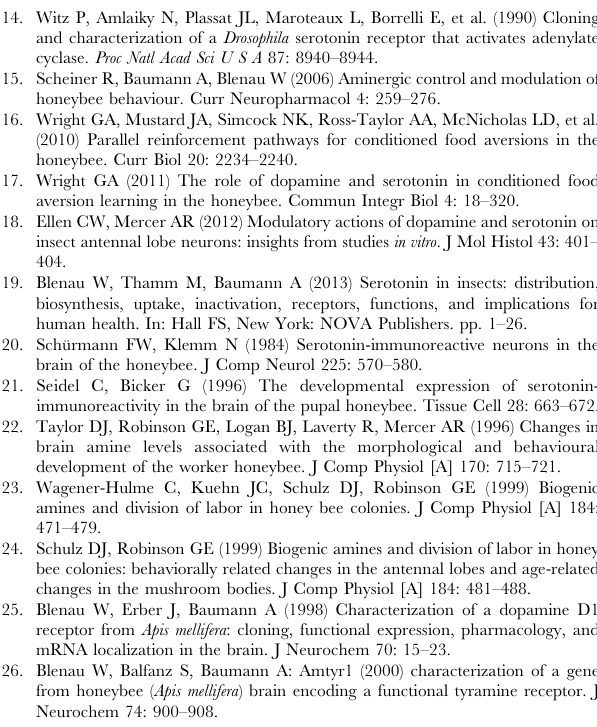
four 5-ht2 genes (red arrow). Two additional splices sites are conserved in the two 5-ht2 a genes only (green arrows) whereas the two 5-ht2 b genes have one additional splice site in common (blue arrow). Figure S4 Tissue-specific expression patterns of Am5- ht2 receptor genes in drones determined by quantitative real-time PCR. Transcript levels were normalized to Amef-1 a . ( A ) Relative levels of receptor-gene mRNAs in the brain of drones ( Am5-ht2 a and Am5-ht2 aD III : n= 10; Am5-ht2 b : n =6; Am5- ht2 bD II : n= 5). ( B ) Relative levels of receptor-gene mRNAs in the ventral nerve cord of drones ( Am5-ht2 a , Am5-ht2 aD III , and Am5-ht2 b : n = 7; Am5-ht2 bD II : n =6). Groups that differed significantly in relative mRNA levels within a given tissue are indicated with different letters above the box plots (p , 0.05, Bonferroni’s multiple comparison test). Table S1 Sequences of primers used for full-length cloning of Am5-ht2 cDNAs, construction of expression vectors, and production of monoclonal antibodies against Am5-HT 2 a .